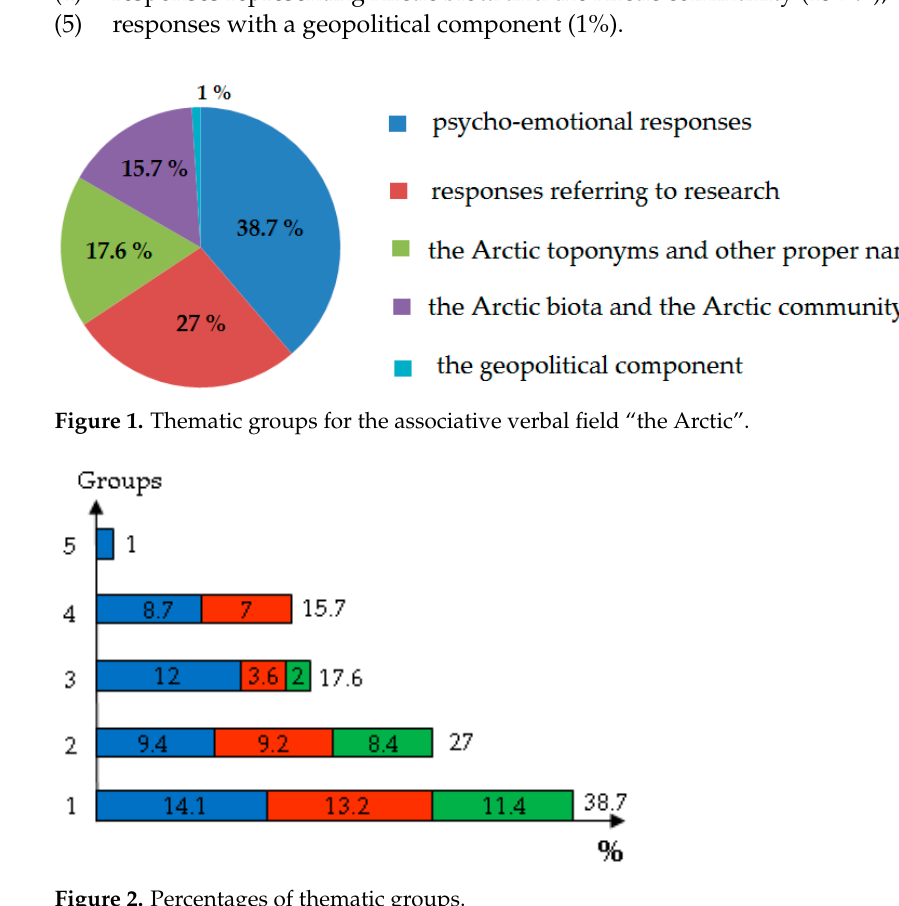
Figure 2. Percentages of thematic groups.